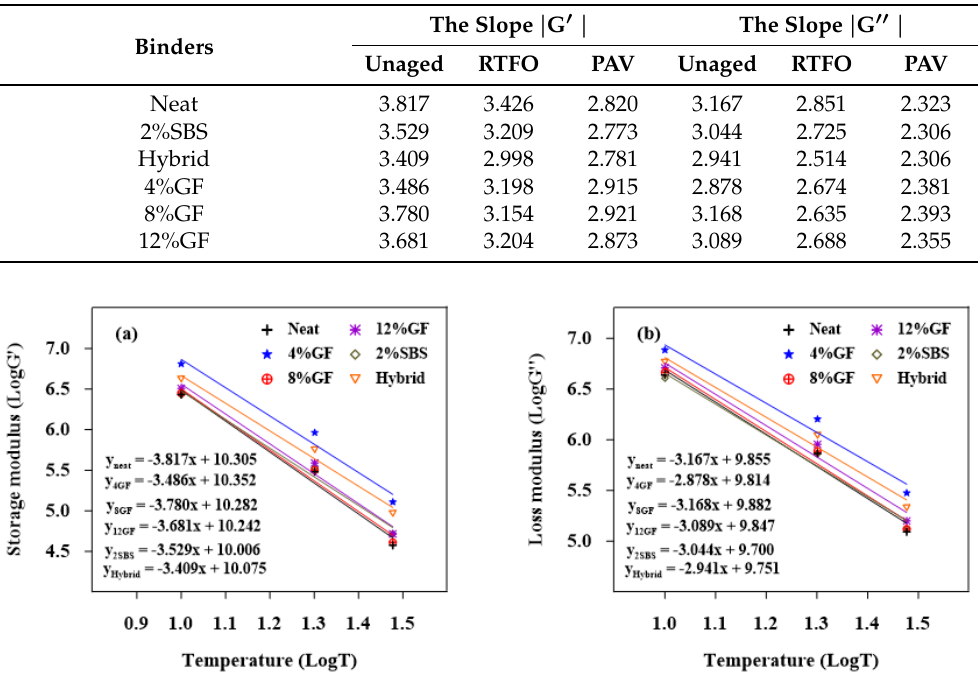
Table 6. Regression slope of unaged, RTFO, and PAV binders.